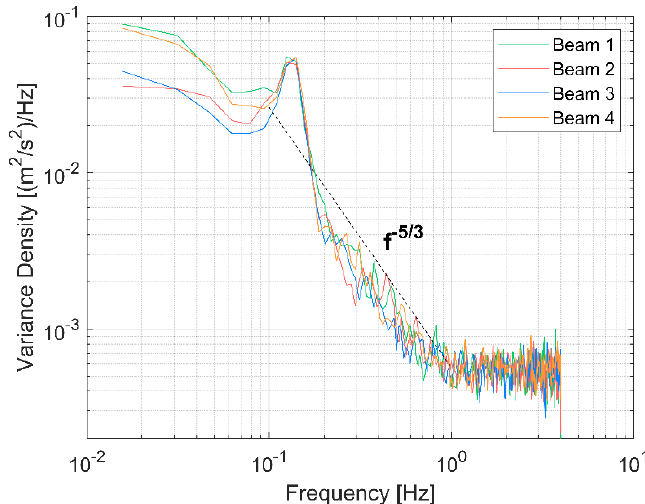
Figure 5. Original turbulent kinetic energy spectrum from velocities measured with each beam of instrument CTb3.